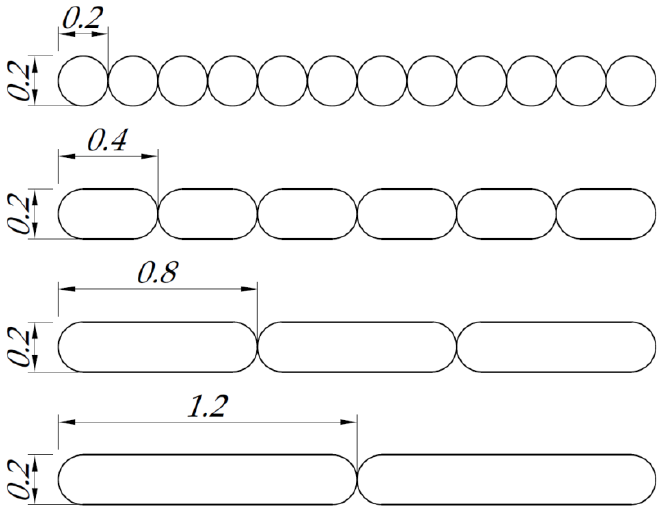
Figure 3. Influence of the diameter of the head nozzle on the overlapping of paths in individual layers.